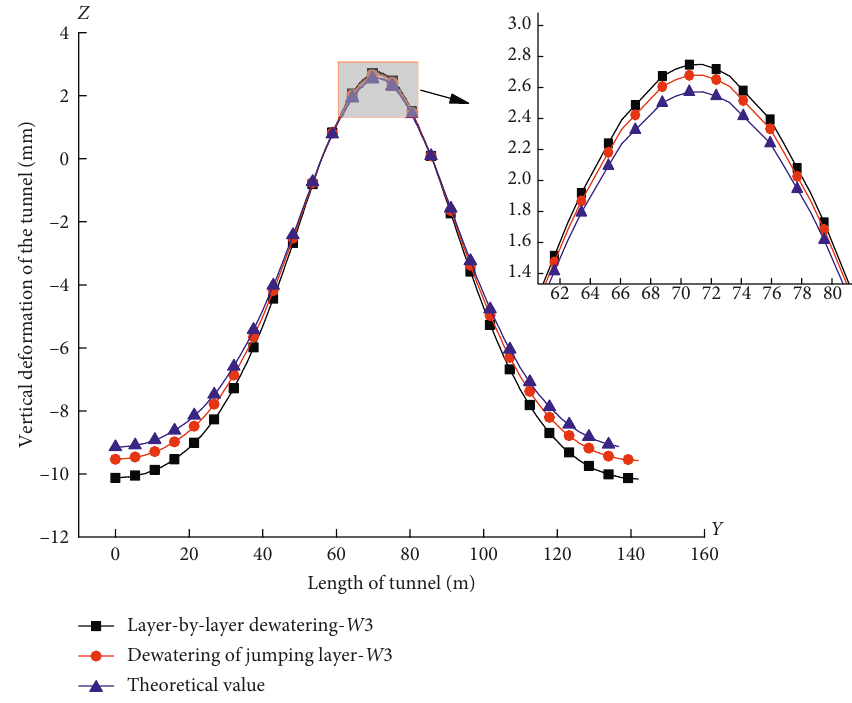
Figure 15: Comparison of deformation and theoretical value of tunnel in W